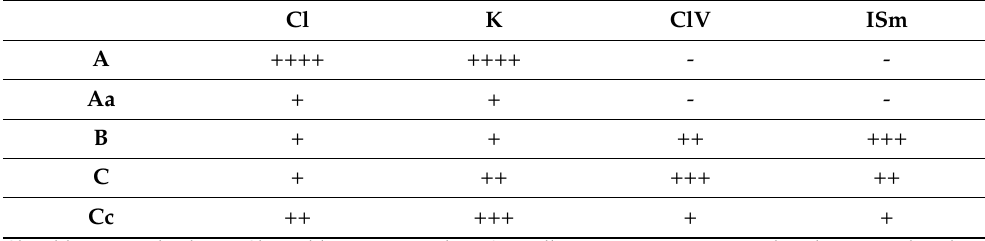
Table 1. Mineralogical composition of clay